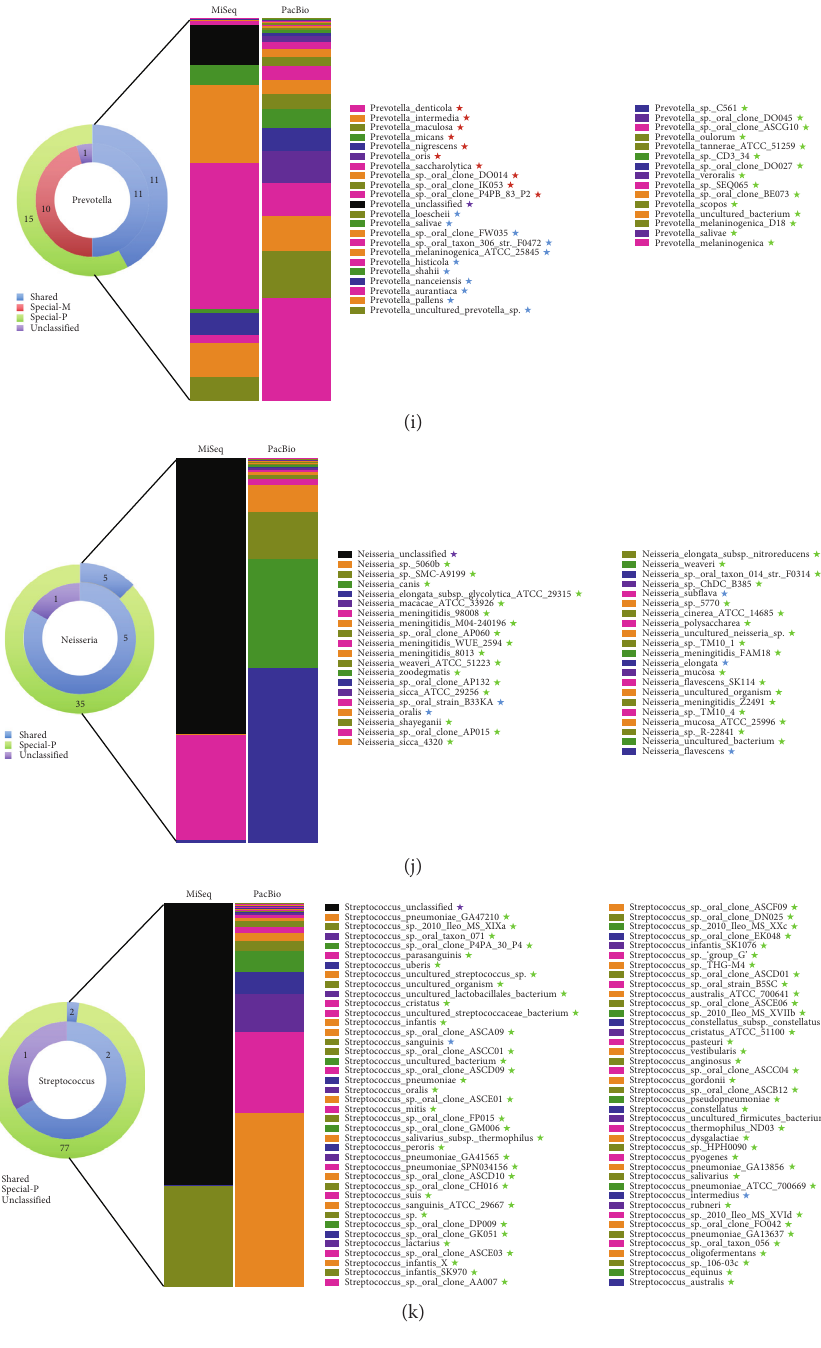
Figure 7: Structure and composition of some particular species sequenced by PacBio and MiSeq platforms. The outer ring of the chart represents the number of species sequenced by the PacBio platform. The inner ring, on the opposite, represents the number of species sequenced by the MiSeq platform. represents the number of species shared by the two platforms, and the detail information was shown on the right bar chart. The star of the same color represents the name of the shared species. represents the number of species generated only by the MiSeq platform, and the detail information was shown on the right bar chart. The star of the same color represents the name of the species only generated by MiSeq. represents the number of unclassified species, and the detail information was marked on the right bar chart. The star of the same color represents the name of the unclassified species. represents the number of species generated only by the PacBio platform, and the detail information was shown on the right bar chart. The star of the same color represents the name of the species only generated by PacBio. (a–k) represents the species of Actinomyces , Campylobacter , Rothia , Haemophilus , Fusobacterium , Gemella , Selenomonas , Veillonella , Prevotella , Neisseria , and Streptococcus ,